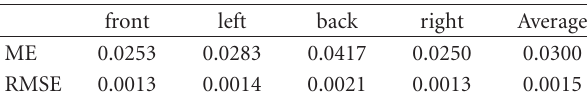
Table 1: Error comparisons between MC and real experiment.